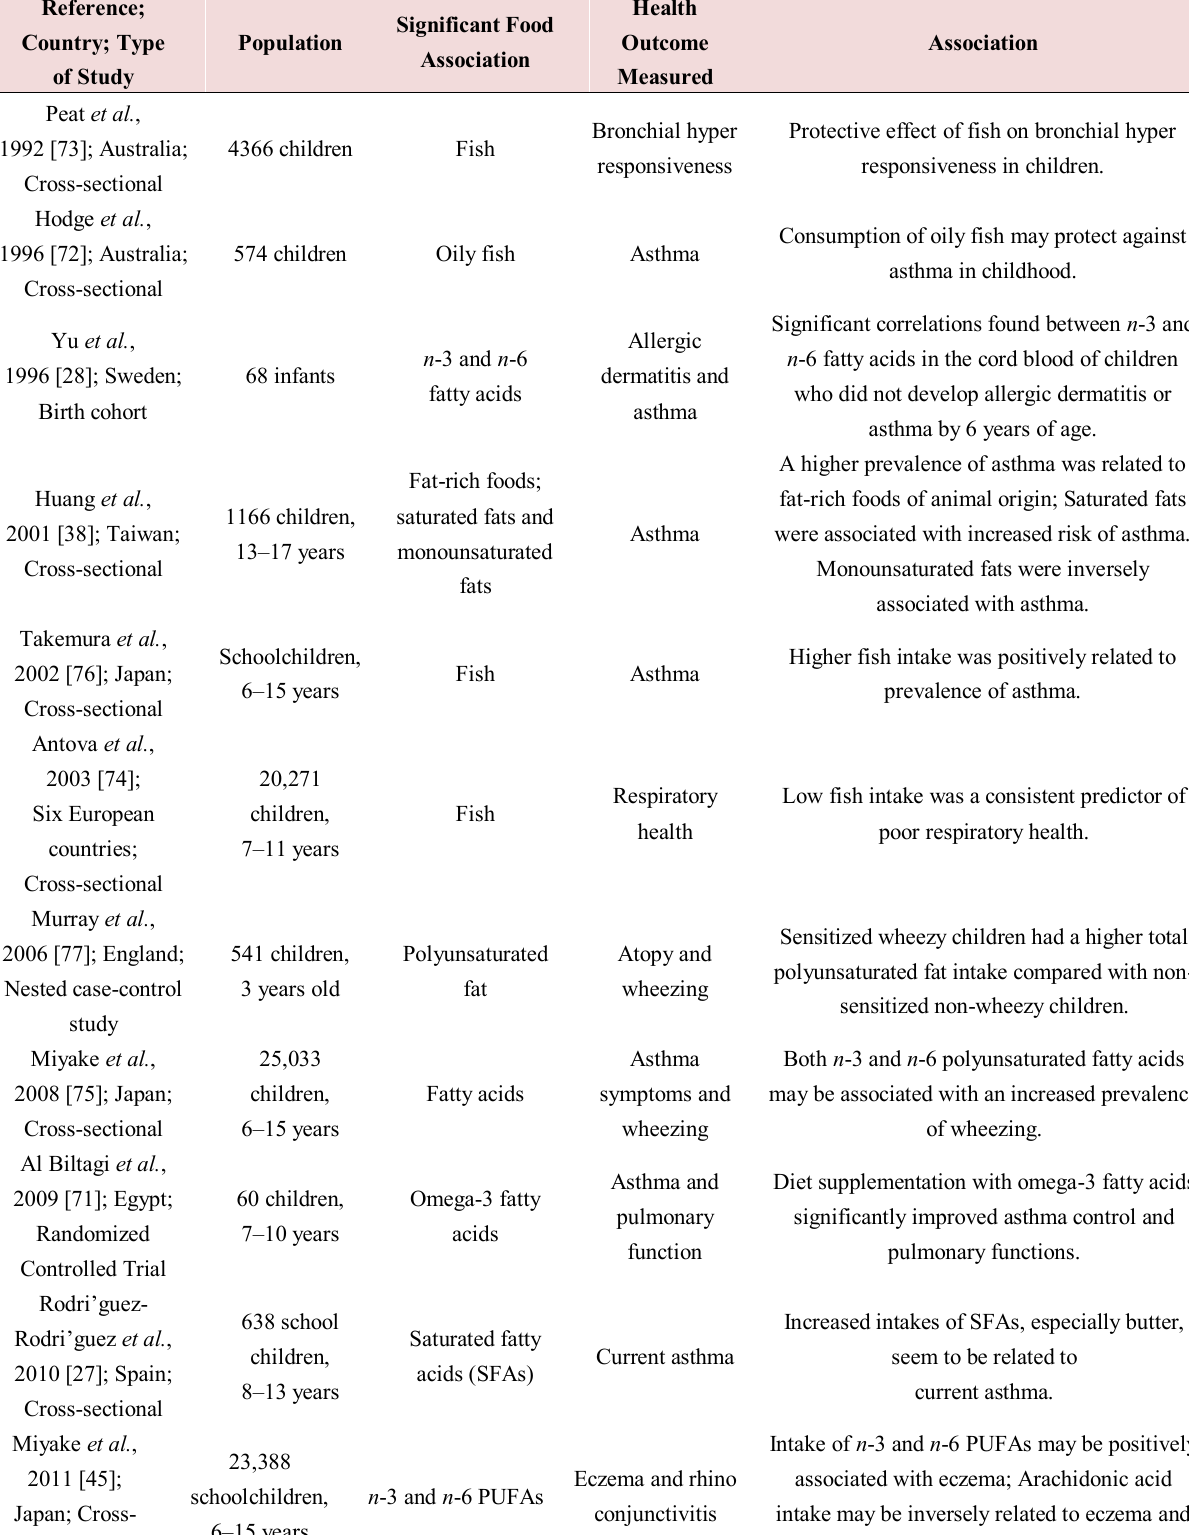
Table 3. Reviewed studies on fish and fat intake in infants and children and their association with allergic